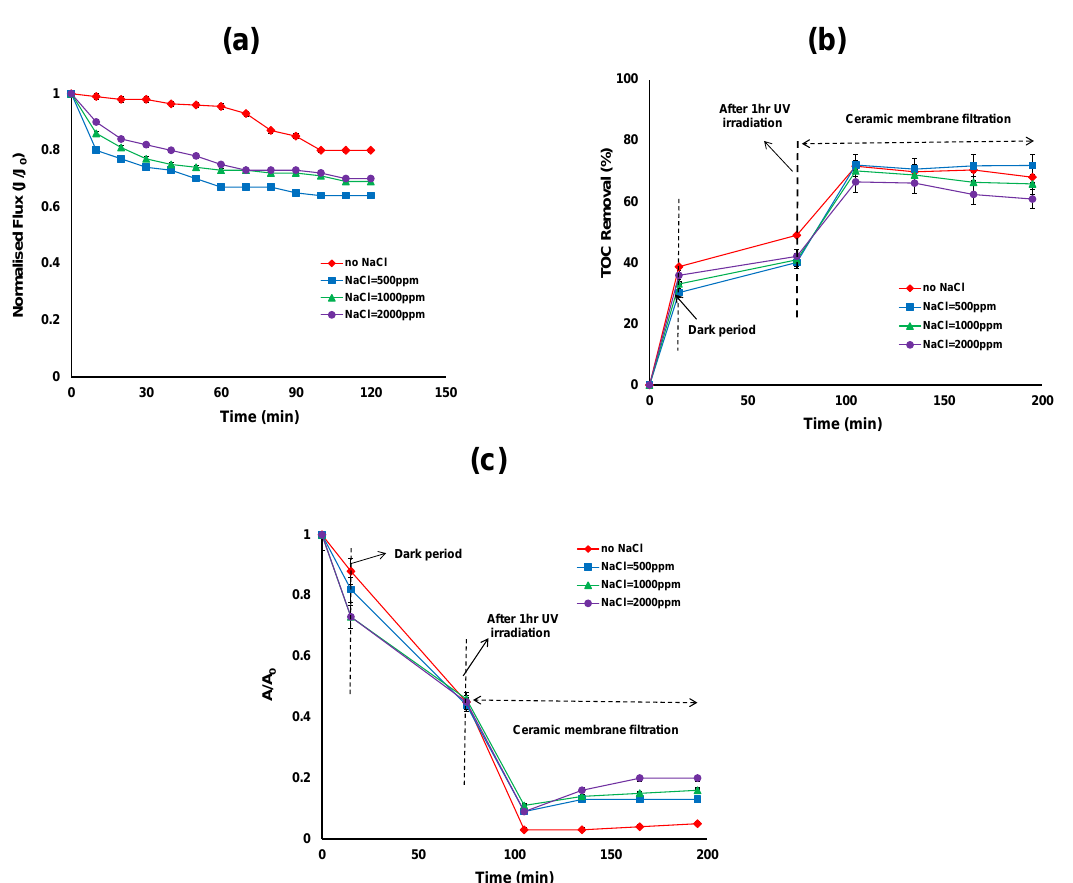
Figure 3. ( a ) Permeate flux ( b ) Total organic carbon (TOC) removal efficiency; ( c ) reduction in UV absorbance of the photocatalytic—ceramic membrane integrated system for various NaCl concentrations (HA concentration: 20 mg/L, TiO 2 concentration: 0.5 g/L, TMP: 100 kPa, CFV: 0.4 m/s; pH: 7.5; UV intensity: 3.4 mW/cm 2 ).